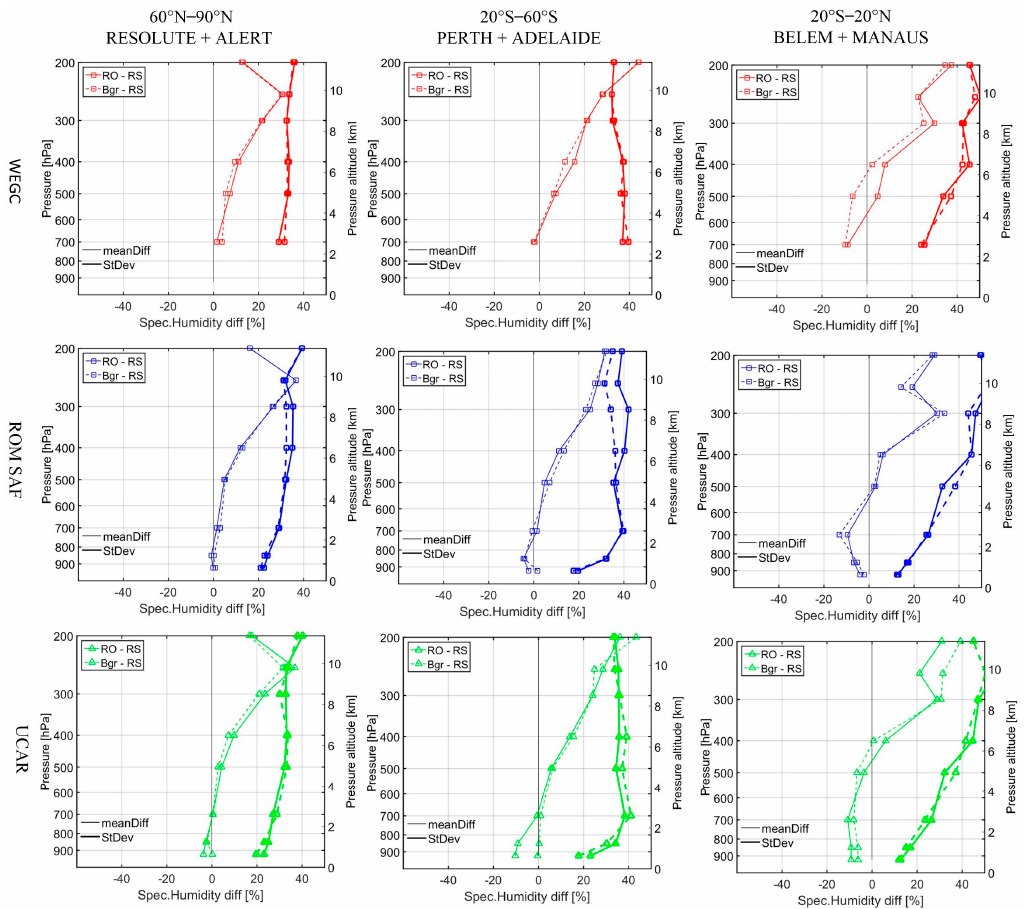
Figure 7. Specific humidity mean di ff erences (meanDi ff ) and standard deviations (Stdev) between RO retrieved profiles and RS (RO-RS) and that between background profiles and RS (Bgr-RS) at stations in three selected latitudinal bands of 60 ◦ –90 ◦ N, 20 ◦ –60 ◦ S and 20 ◦ S–20 ◦ N; top, middle and bottom rows show for results of WEGC, ROM SAF and UCAR,